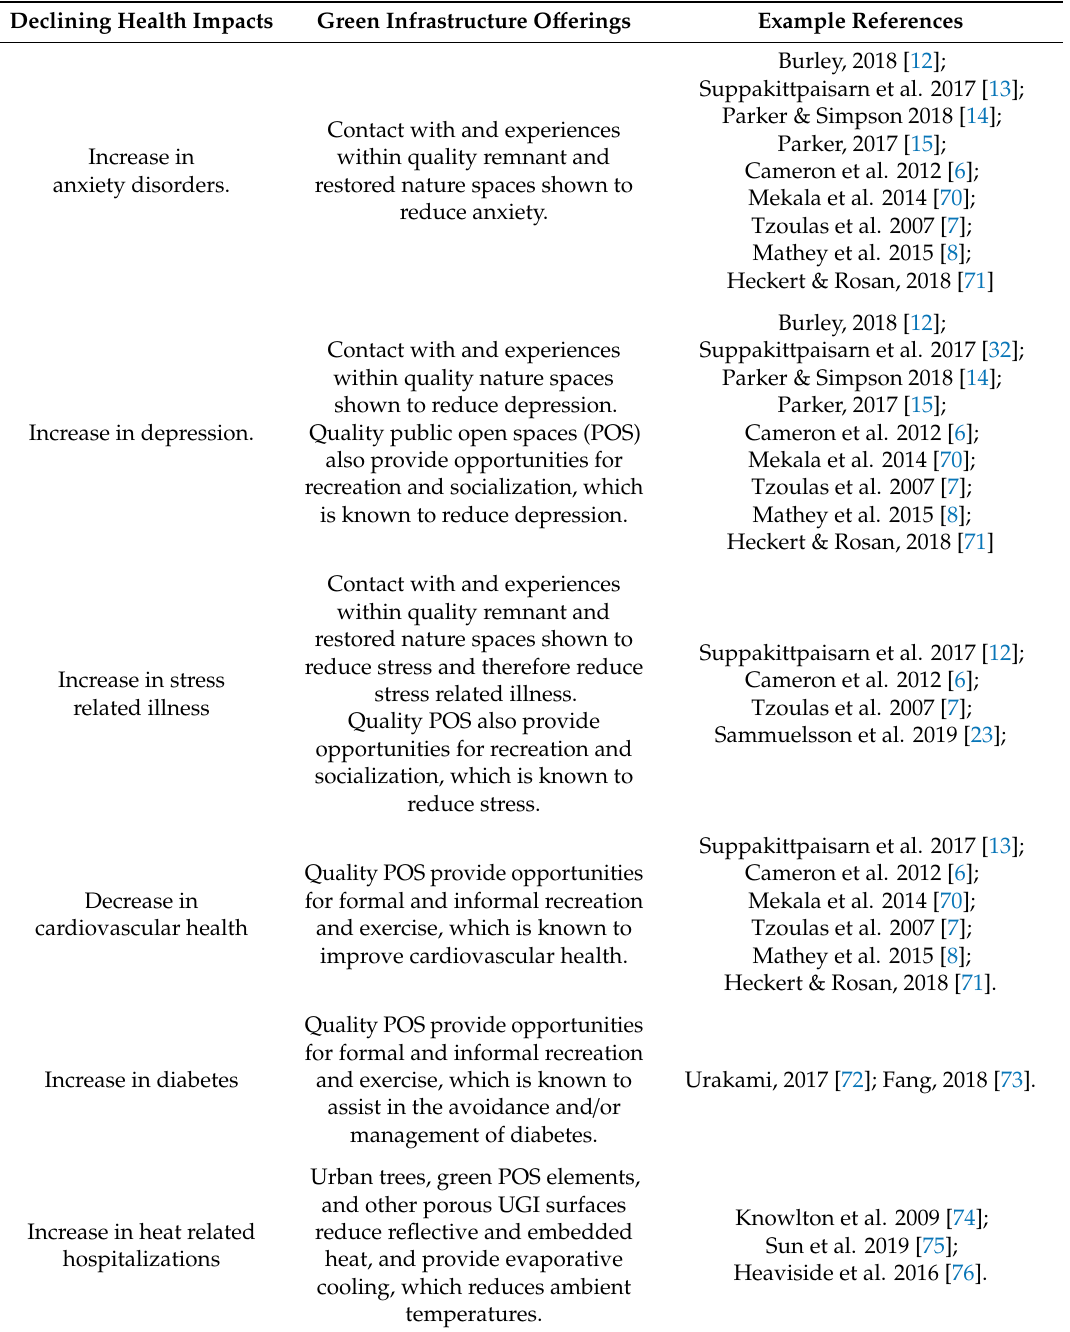
Table 2. Examples of urban green infrastructure o ff erings that could mitigate and / or meditate impacts arising from the crisis of declining human health in urban